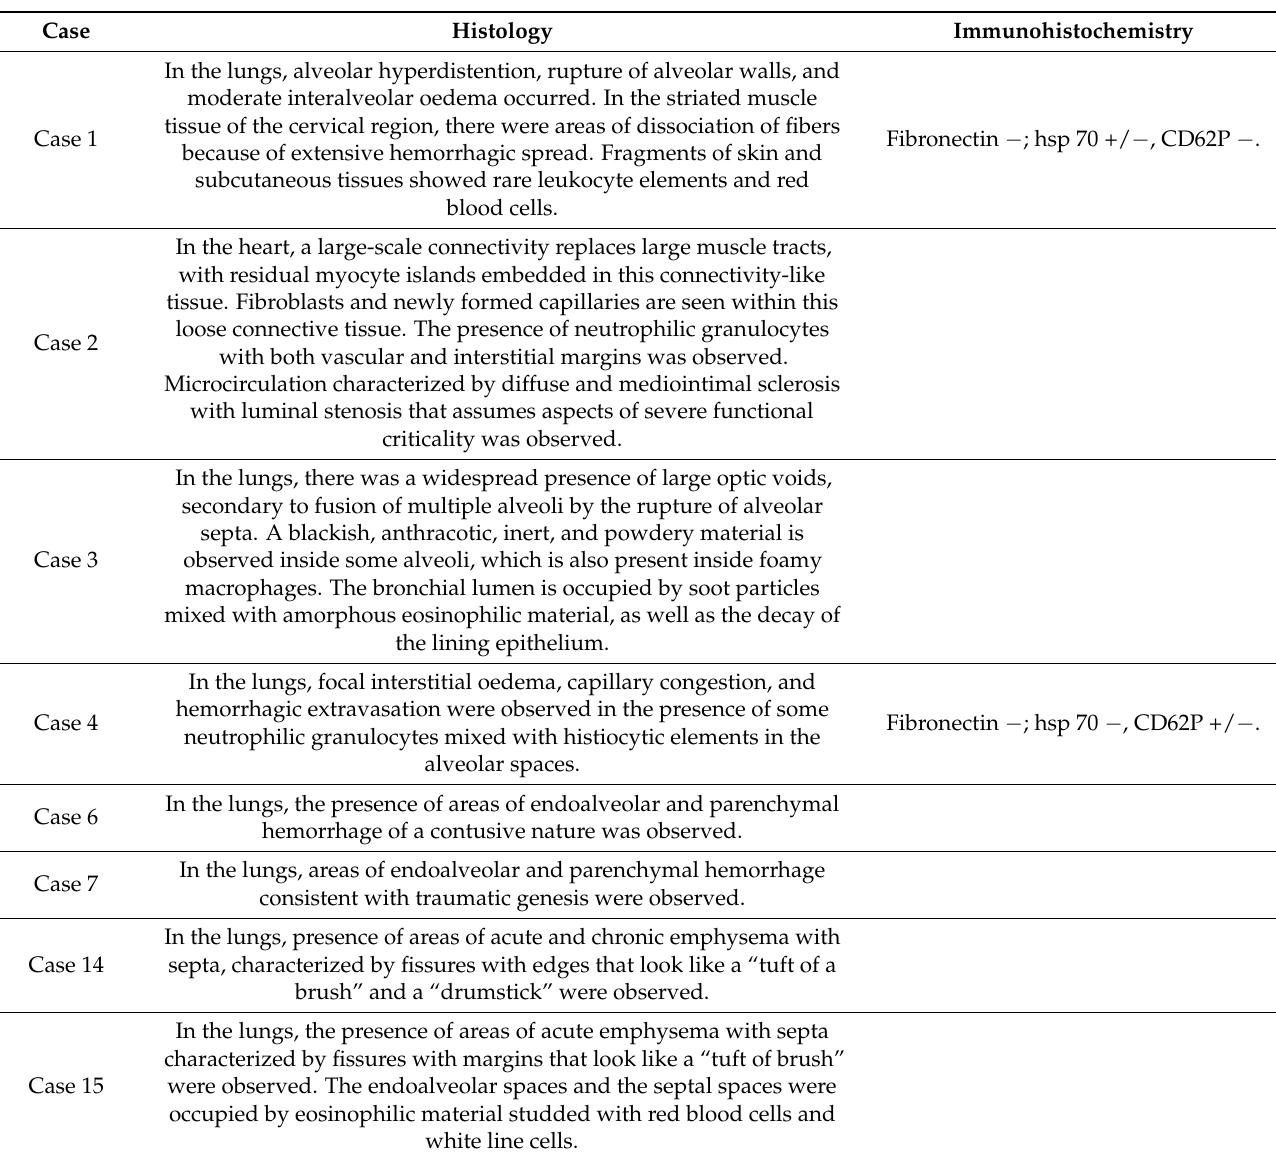
Table 5. Table resumes histological and immunohistochemical findings performed in a total of 60/82 cases. [N] indicates that analyses were performed on neck skin, not in the lung, while [S] means “skin